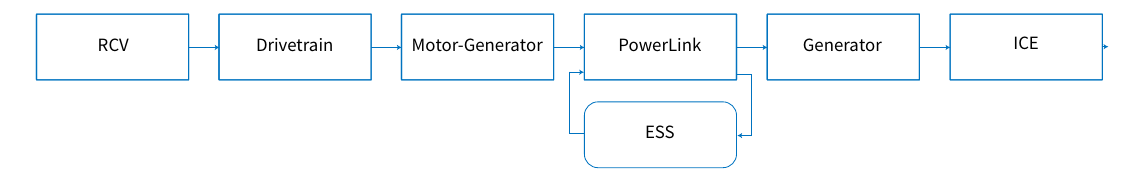
Figure 1. Quasi-static model of an HE – RCV .